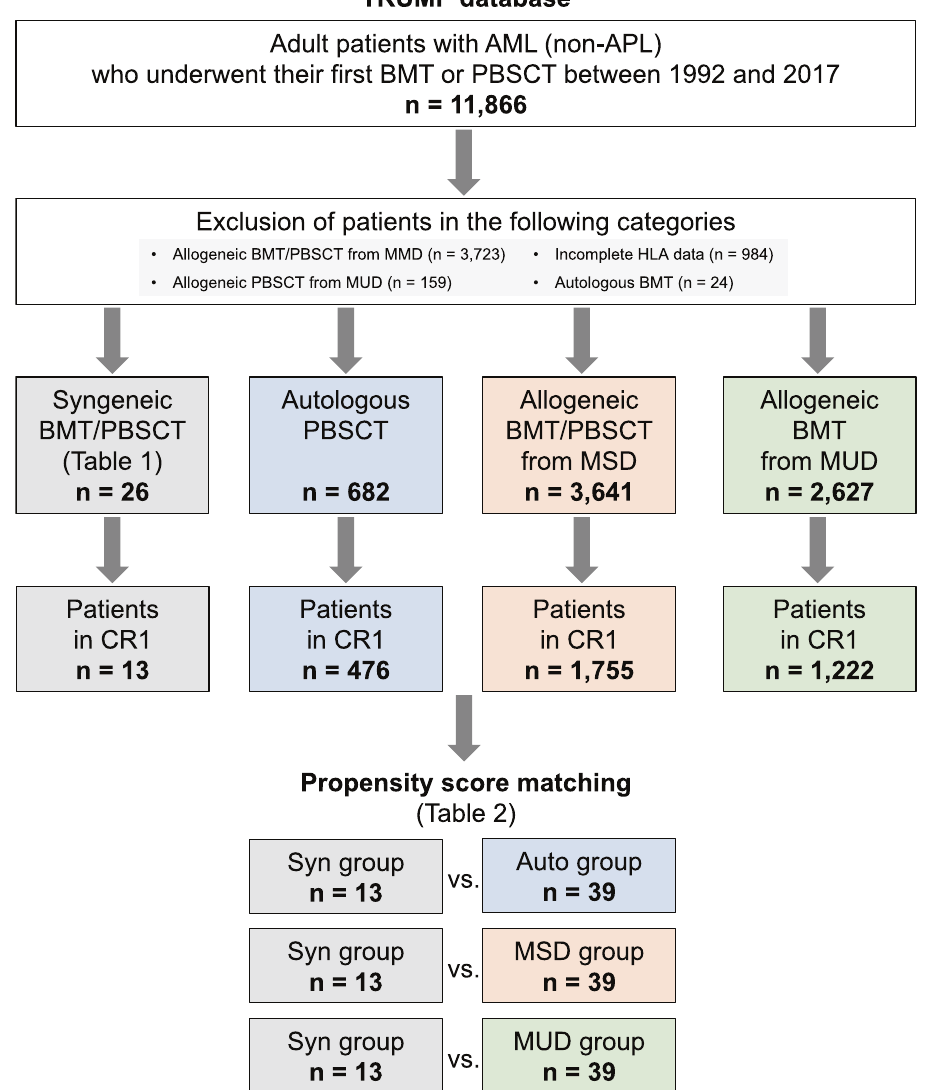
Fig. 1 Patient selection fl owchart and study design. AML acute myeloid leukemia, APL acute promyelocytic leukemia, Auto autologous, BMT bone marrow transplantation, CR1 fi rst complete remission, HLA human leukocyte antigen, MMD mismatched donor, MSD matched sibling donor, MUD matched unrelated donor, PBSCT peripheral blood stem cell transplantation, Syn syngeneic, TRUMP Transplant Registry Uni fi ed Management